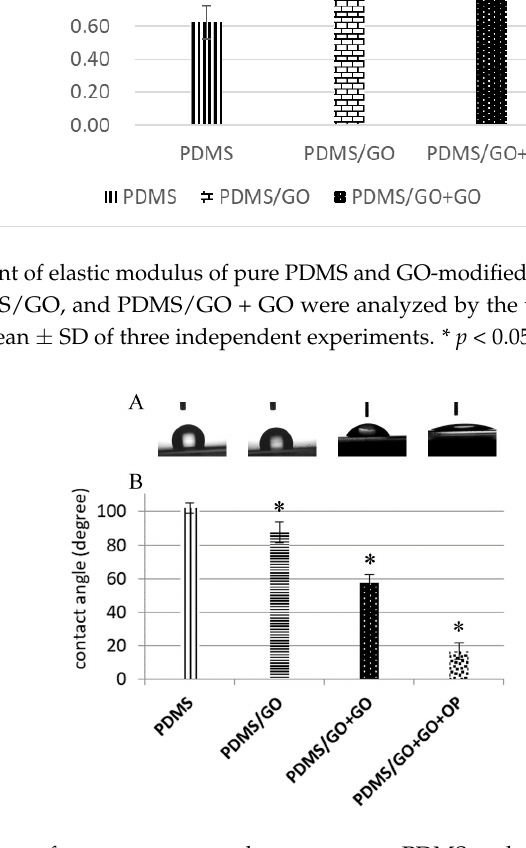
Figure 3. Measurement of water contact angle among pure PDMS and other GO-modified PDMS elastomers. ( A ) Representative images of water drops on the surface of PDMS, PDMS/GO, PDMS/GO + GO, and PDMS/GO + GO exposed to oxygen plasma treatment (PDMS/GO + GO + OP). ( B ) Water contact angle among pure PDMS, PDMS/GO, PDMS/GO + GO, and PDMS/GO + GO with exposure to oxygen plasma treatment were measured by a sessile drop tensiometer. * p < 0.05 vs. PDMS. The results are the mean ± SD of three independent experiments. * p < 0.05 vs. PDMS.